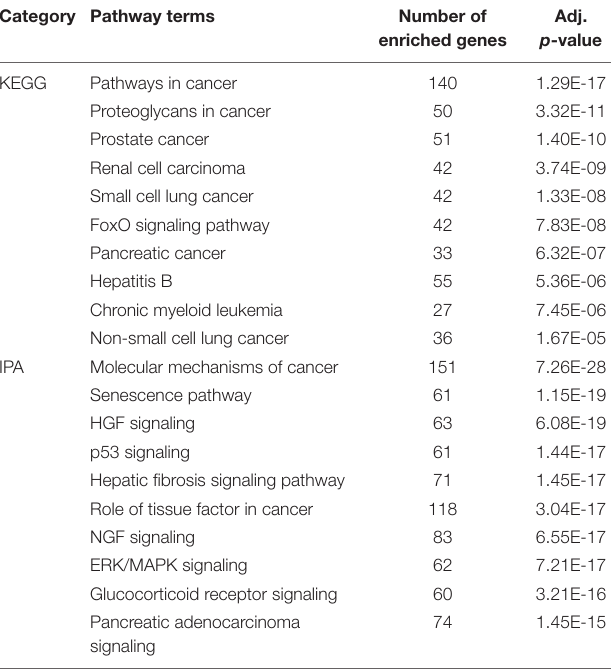
TABLE 3 | The 10 pathways most significantly enriched by targets of the reported